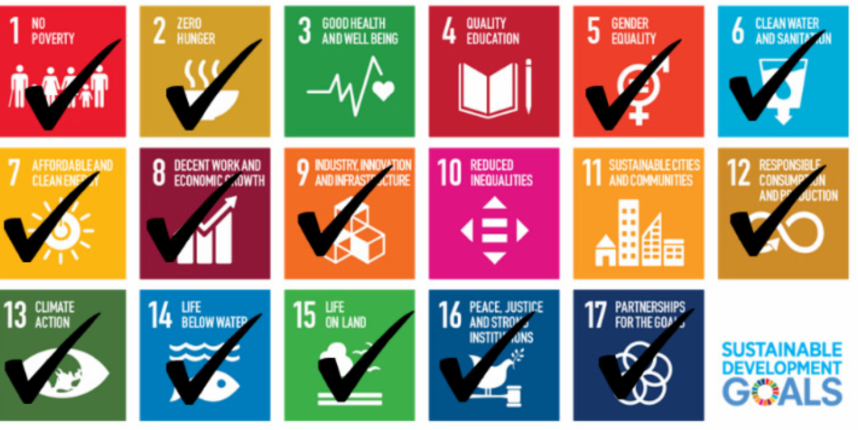
Figure 9. Sustainable development goals (SDGs) addressed under the MENA Grand